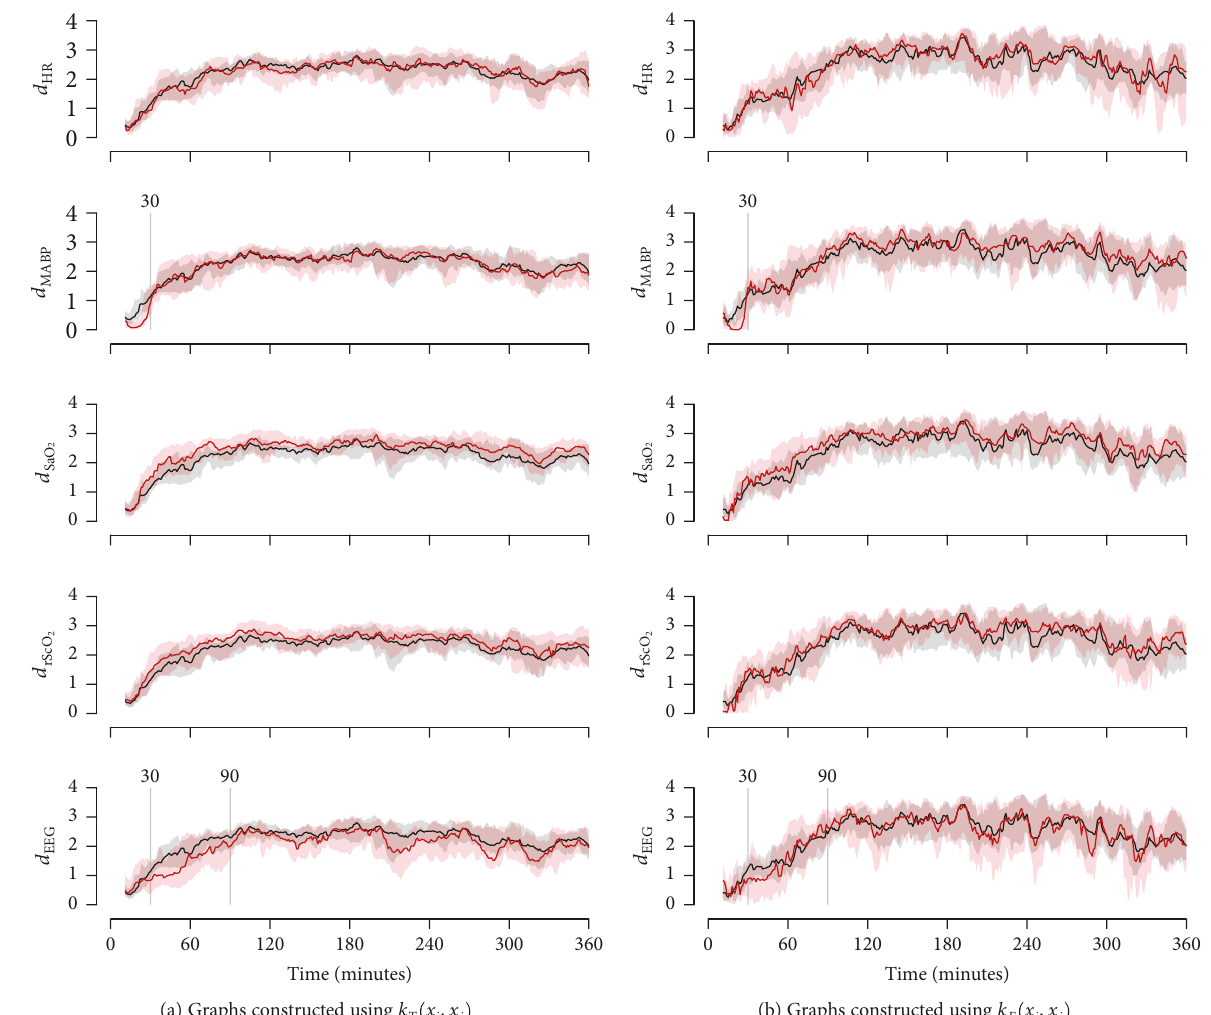
Figure 9: Comparing the vertex degree values (red) with the graph average degree (black) after administration of propofol at t =0minutes. The graph models were constructed using k T x i , x j (a) and k F x i , x j (b). The results are presented for the whole group of study ( N = 22 ). is compared to the graph average degree δ G for HR, MABP, SaO From top to bottom, the vertex degree d i respectively. d highly determines the signal interaction pattern during the fi rst 30 minutes after propofol administration, while d MABP highly in fl uences the signal interaction pattern from 30 minutes to 90 minutes after propofol administration. After 90 minutes, the neonates are recovered from propofol, as indicated by the steady reference levels observed after 90